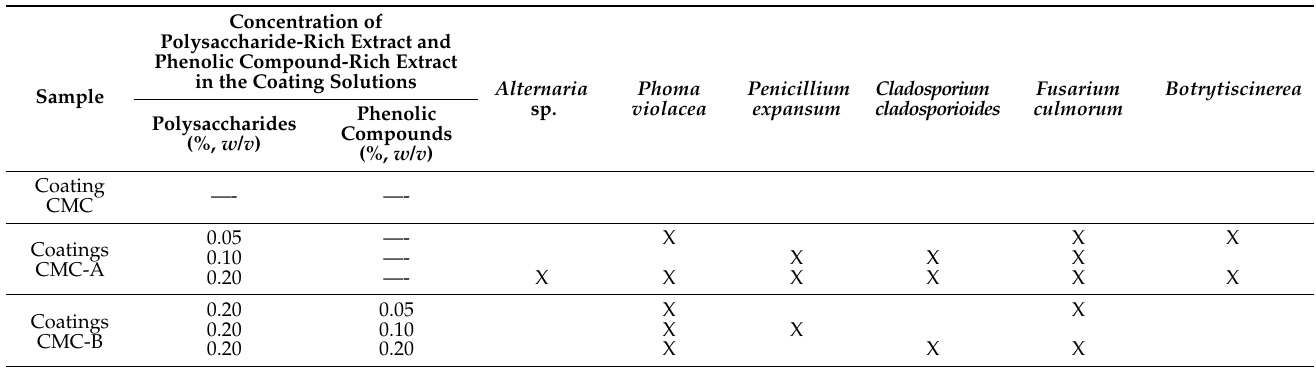
Table 2. Antimicrobial activity of the CMC-based coating solutions against the growth of different microbial